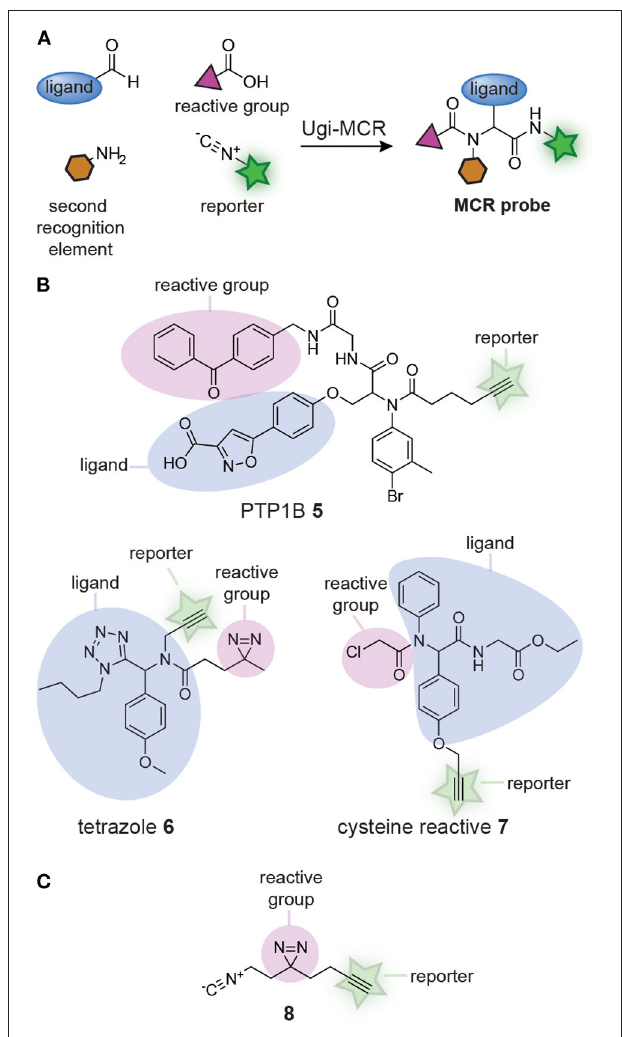
FIGURE 2 | (A) Schematic representation of probe synthesis by multicomponent reactions (MCRs). Ligands can be combined with reactive groups and reporter groups to generate probes in a single step. (B) Examples of probes discovered by screening probe libraries prepared via MCRs. (C) Structure of the isocyanide building block ( 8 ), containing both a diazirine reactive group and an alkyne reporter group, developed by Jackson and Lapinsky, that can be used for the synthesis of MCR